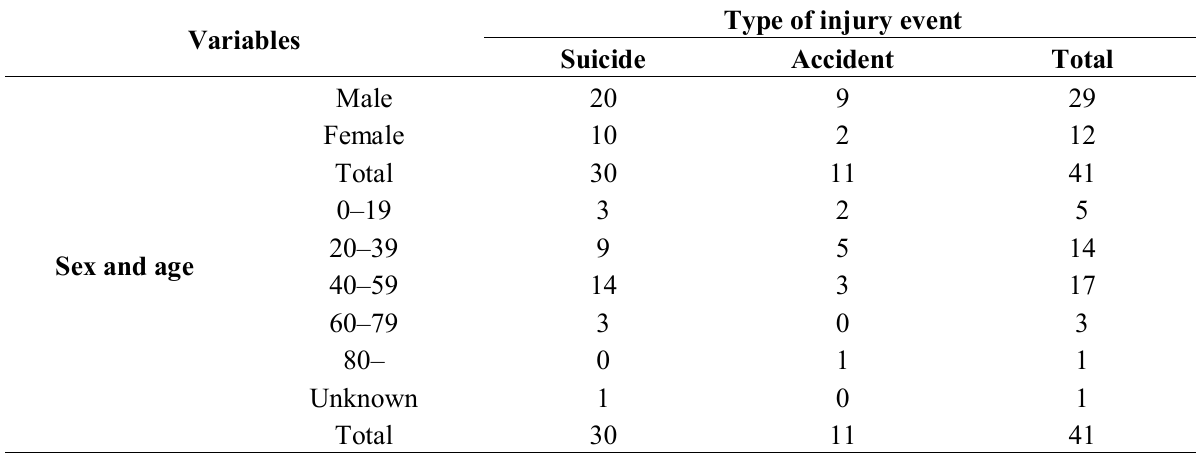
Table 1. Fatal train-person collisions by sex, age, and injury intent on railway property in the greater Stockholm area, 2005–2008.